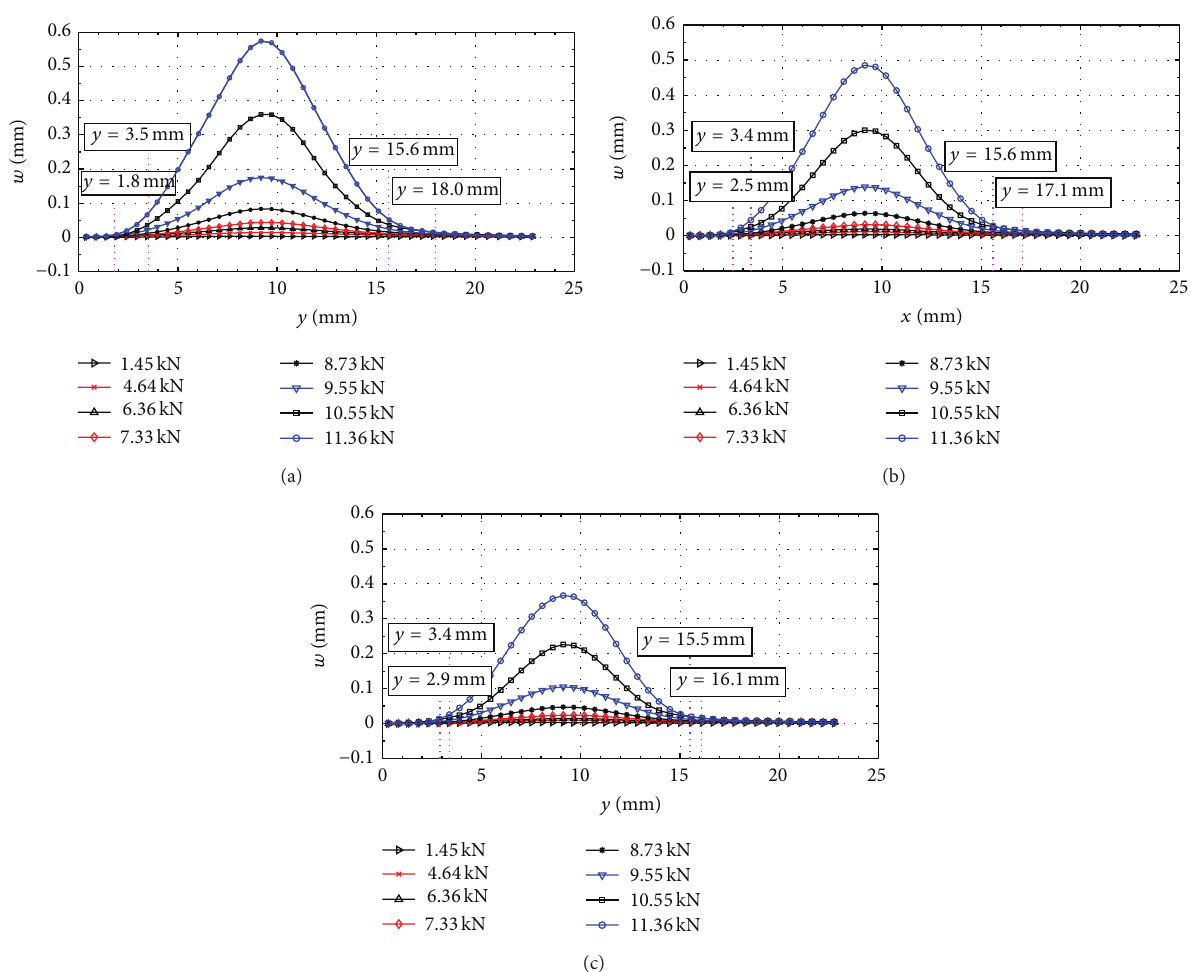
Figure 7: Displacement distribution on different vertical lines: (a) 𝐿 2 , (b) 𝐿 3 , and (c) 𝐿 4 .